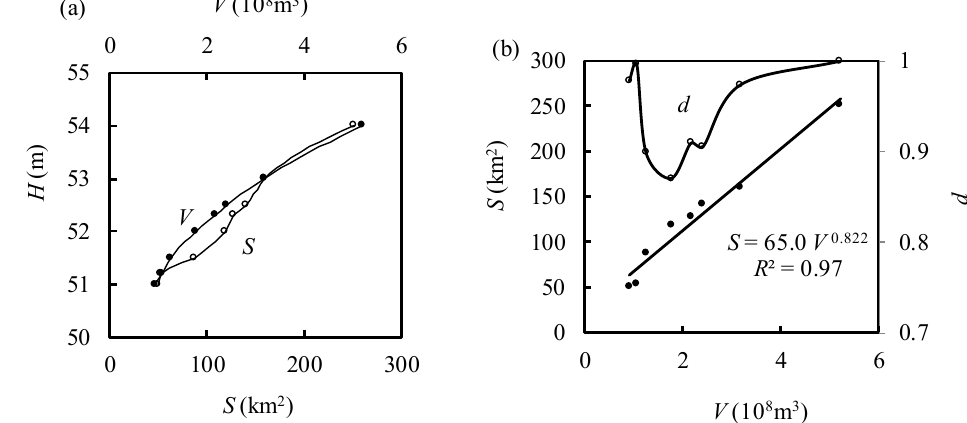
Figure 4. Calculation of the minimum ecological water level for the Honghe wetland using the lake surface area method: ( a ) Water level ( H )-surface area ( S )-storage ( V ) curves [19], and ( b ) S - V and evaluation function ( d )- V curves.